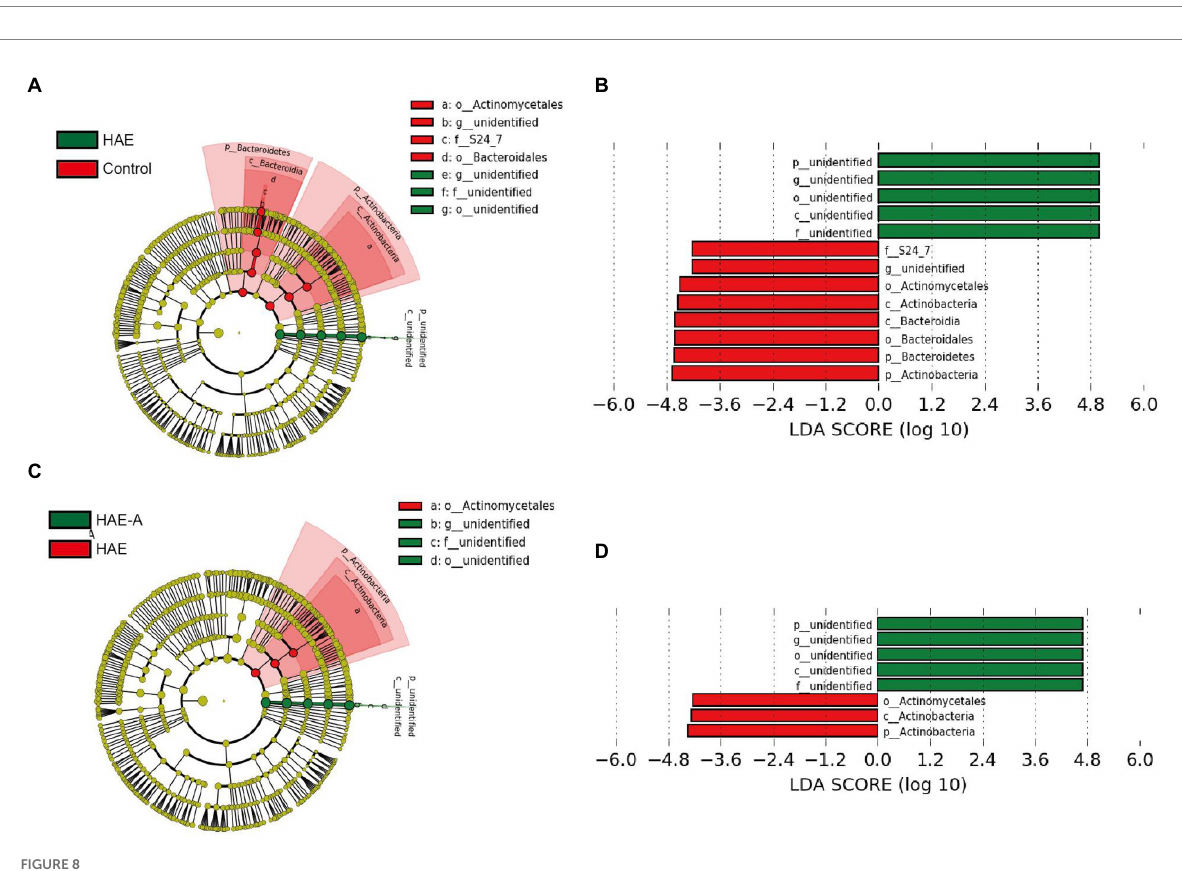
FIGURE 8 LEfSe analysis of colon microbiota in mice. Cladogram (A,C) and linear discriminant analysis (LDA) score (B,D) and cladogram (A,C) were generated from LDA effect size. Taxa with LDA values larger than 4 are shown in the